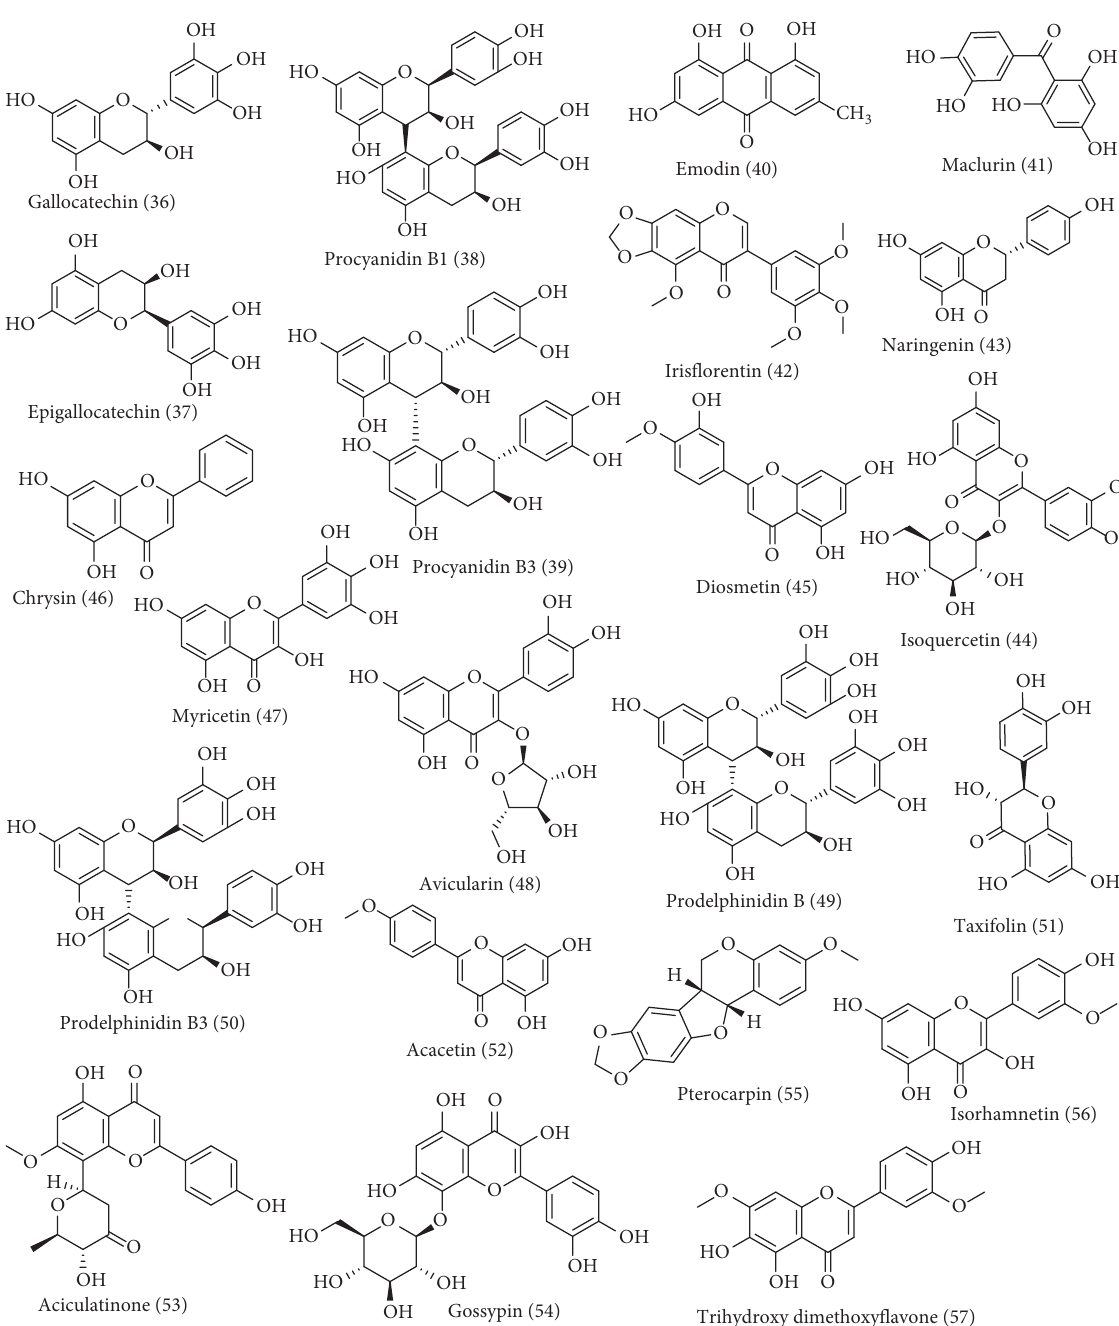
Figure 3: Antidiabetic compounds from Acacia catechu